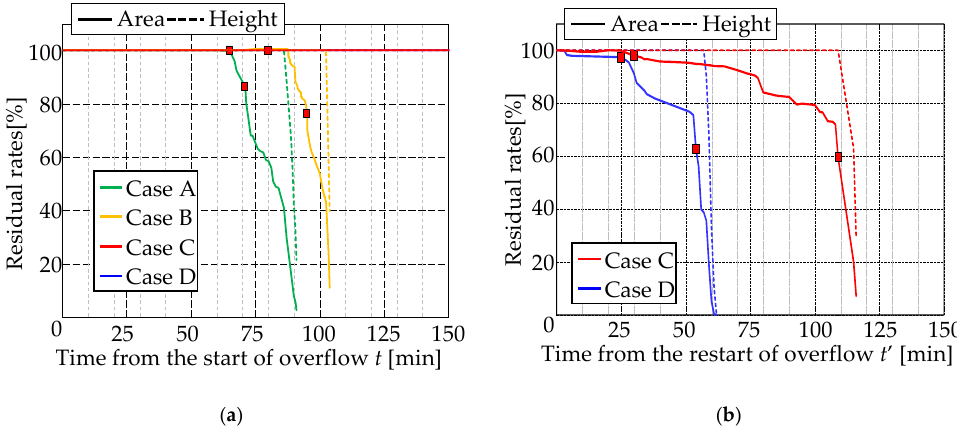
Figure 8. Time series of the residual rates for the cross-sectional area and the crest height in all cases: the results with the scour protection ( a ) and without the scour protection ( b ).